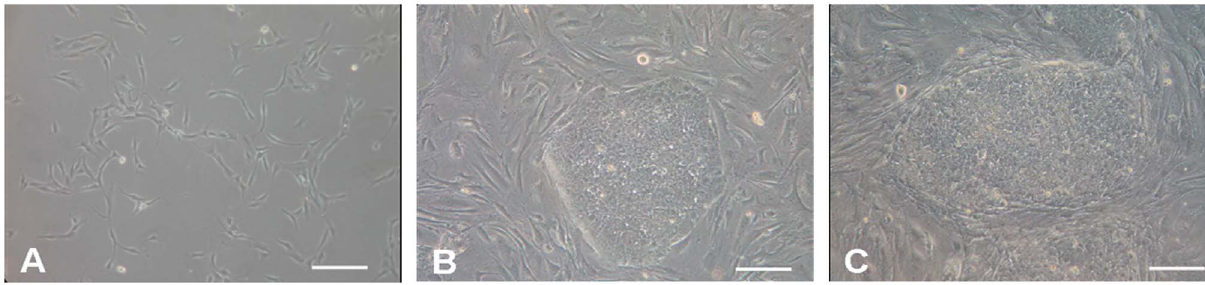
Figure 2. The morphologies of rabbit fibroblast (A), f-rES (B), and p-rES (C) cells grown to log phase. Fertilized-rES cells and p-rES cells were propagated on MEF feeder cells and grown into compact colonies. Scale bar=100 m m.